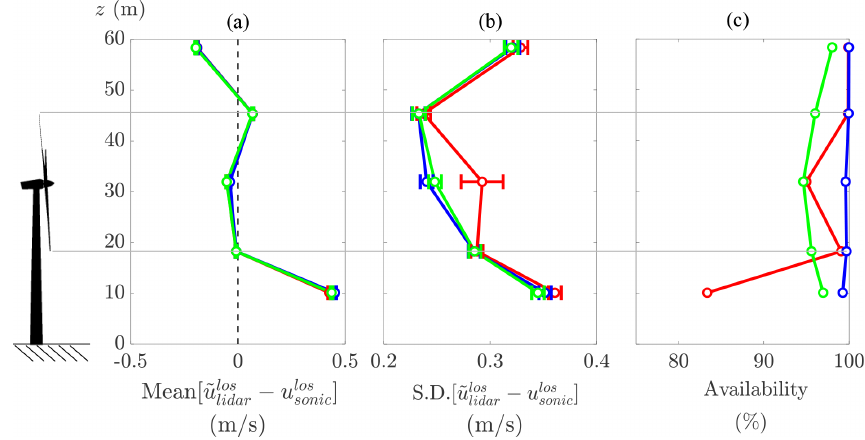
Figure 14. Aggregate results from inflow cases for (a) mean error, (b) , standard deviation (SD) of error, and (c) data availability plotted versus height off the ground. The dimensions of a V27 turbine as used in the experiment are shown for reference. The line colors are thresholding (red), advanced filtering (blue), and machine learning